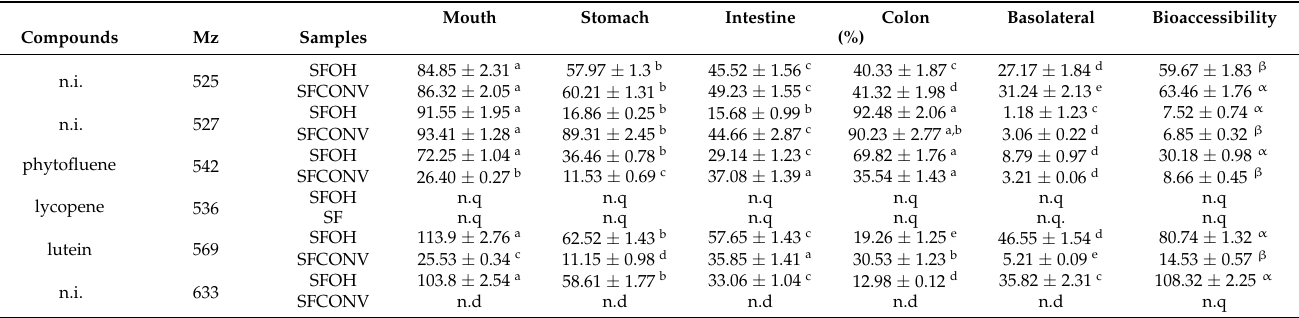
Results are the means of three determinations ± standard deviation; n.i., nonidentified; n.d., nondeterminate; n.q., nonquantified. Different letters in the same row are significantly different ( p < 0.05), the Greek alphabet symbol means significant differences between methods used in the same column ( p < 0.05), as determined by ANOVA ( p <